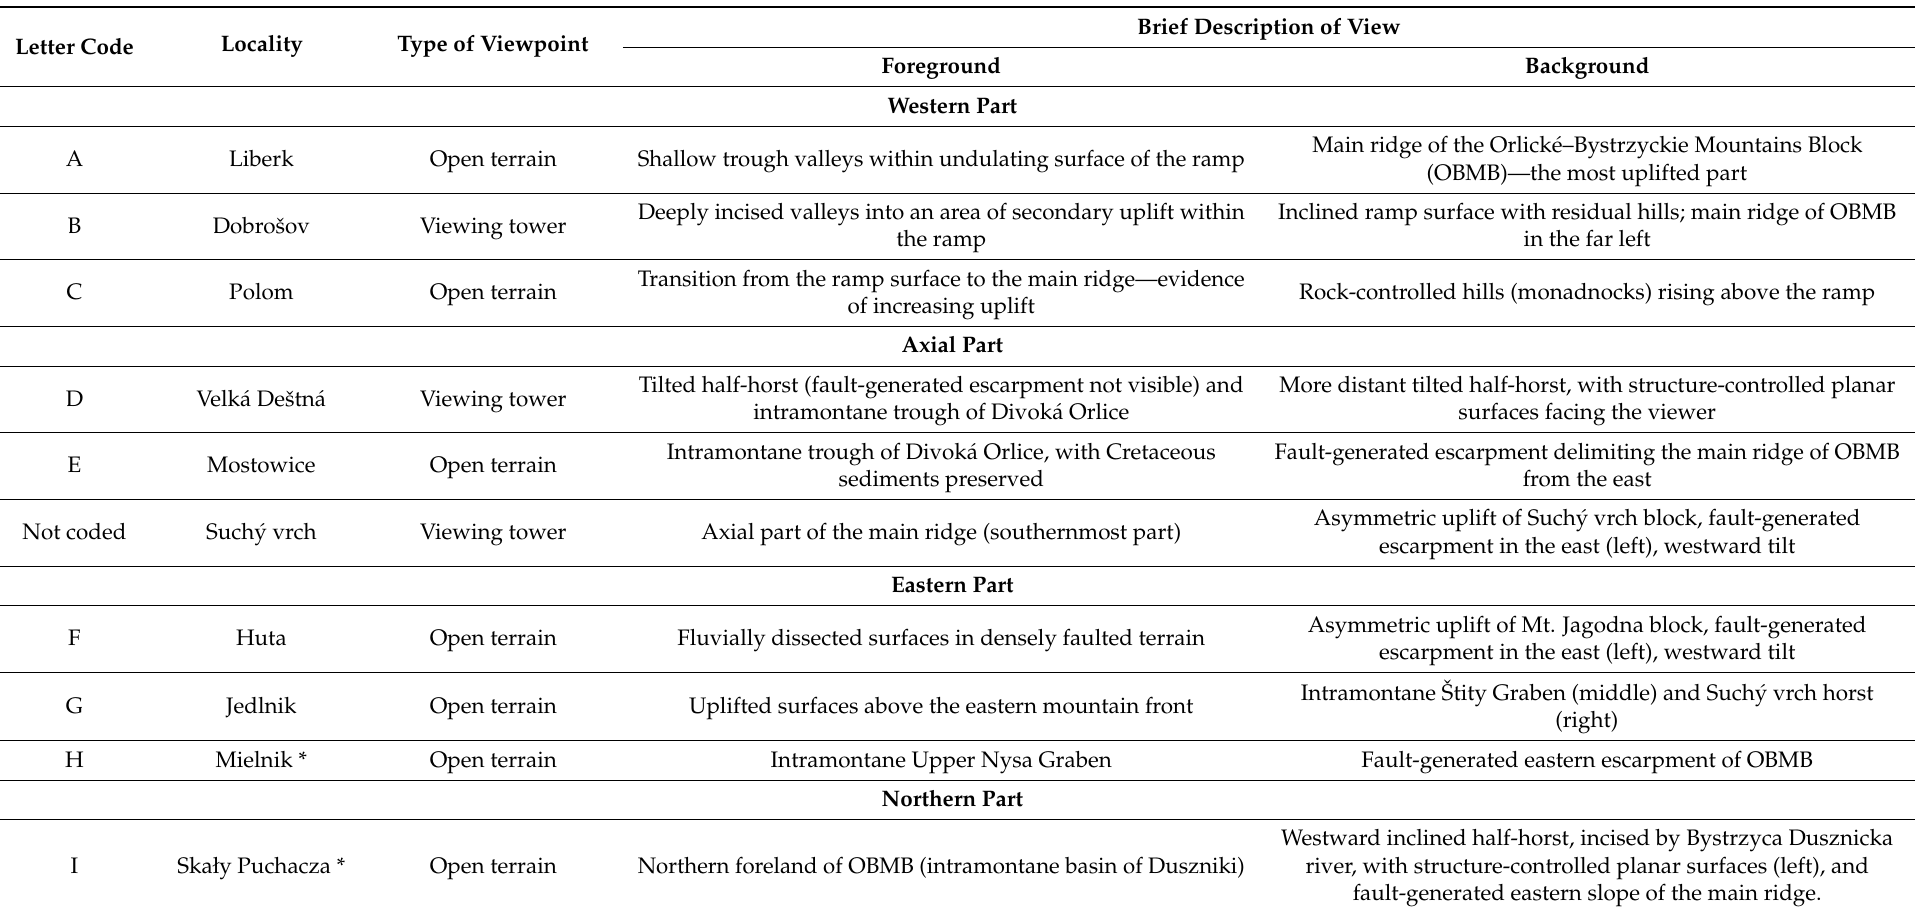
Table 4. Selection of viewpoints which allow to see and interpret the gross relief of the Orlick é –Bystrzyckie Mountains Block. Letter codes correspond with Figure